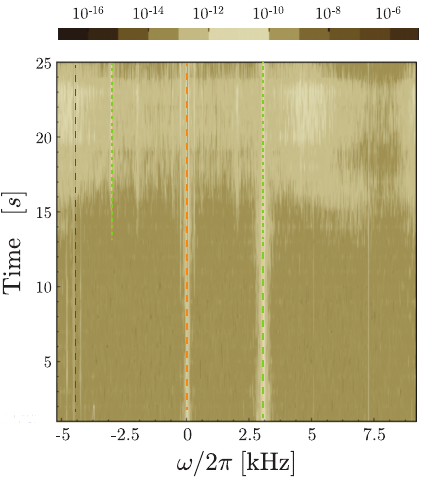
Figure 5. Measured VSN in V 2 Hz − 1 of the output probe beam normalized to the resonant frequency of the fundamental mode of the first membrane, which takes 50 s to arrive to a limit cycle. The pump beam is switched on after 10 s with a power of 4.25 µW. The pump power is further increased to 6.0 µW after 25 s. From the first thermal spectra we derive the following optomechanical param- eters: ω 1 (cid:39) 2 π × 230.795 kHz, g 1 (cid:39) 2 π × 0.43 Hz, ω 2 (cid:39) 2 π × 233.759 kHz, g 2 (cid:39) 2 π × 0.70 Hz. Orange-dashed and green-dashed lines indicate the first and second fundamental mode, respectively. Magenta-dashed line indicates the calibration signal at ω b = 2 π × 226.000